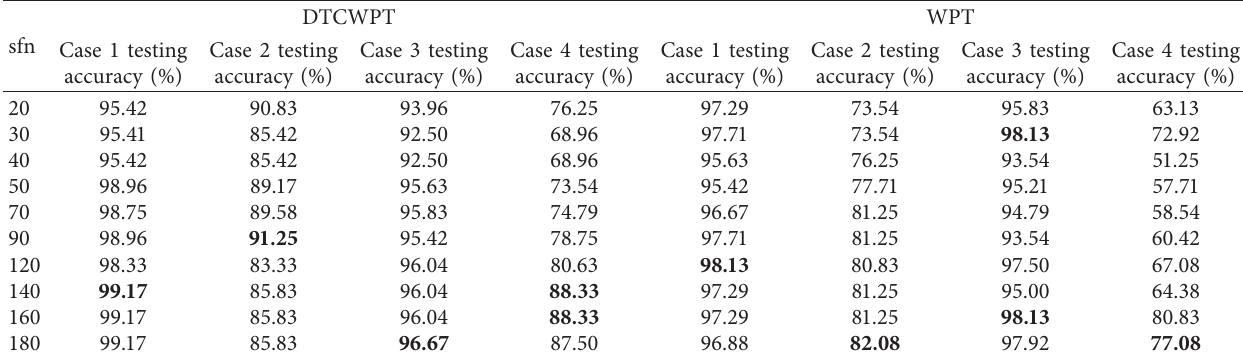
Table 13: Testing accuracies obtained by